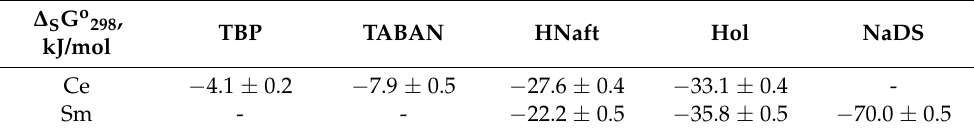
Table 6. Gibbs energy of solvation when extracting Ce and Sm by different extractants